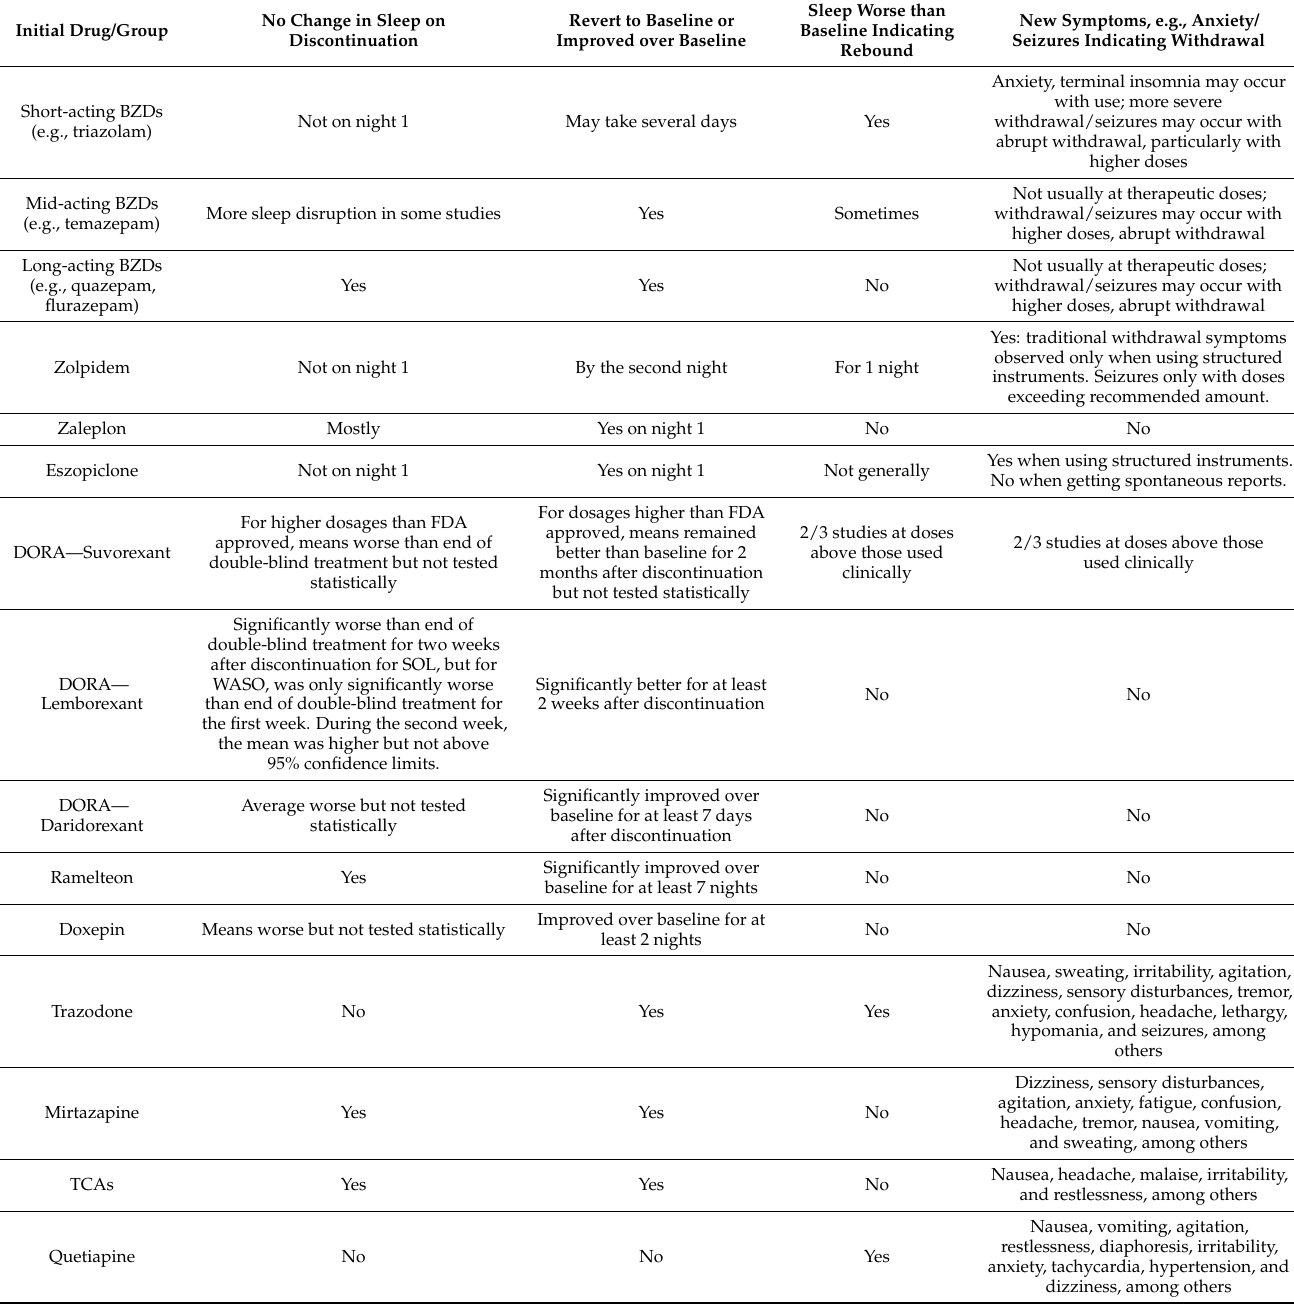
Table 1. Summarized observed effects of insomnia medication discontinuation or